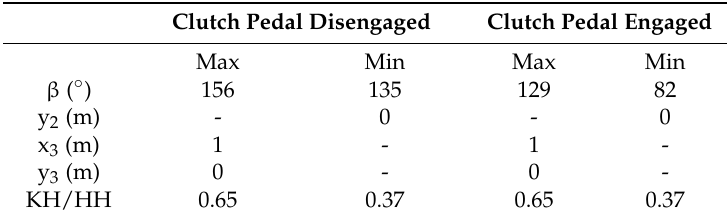
Table 7. Variable limits based on the completed driving test.